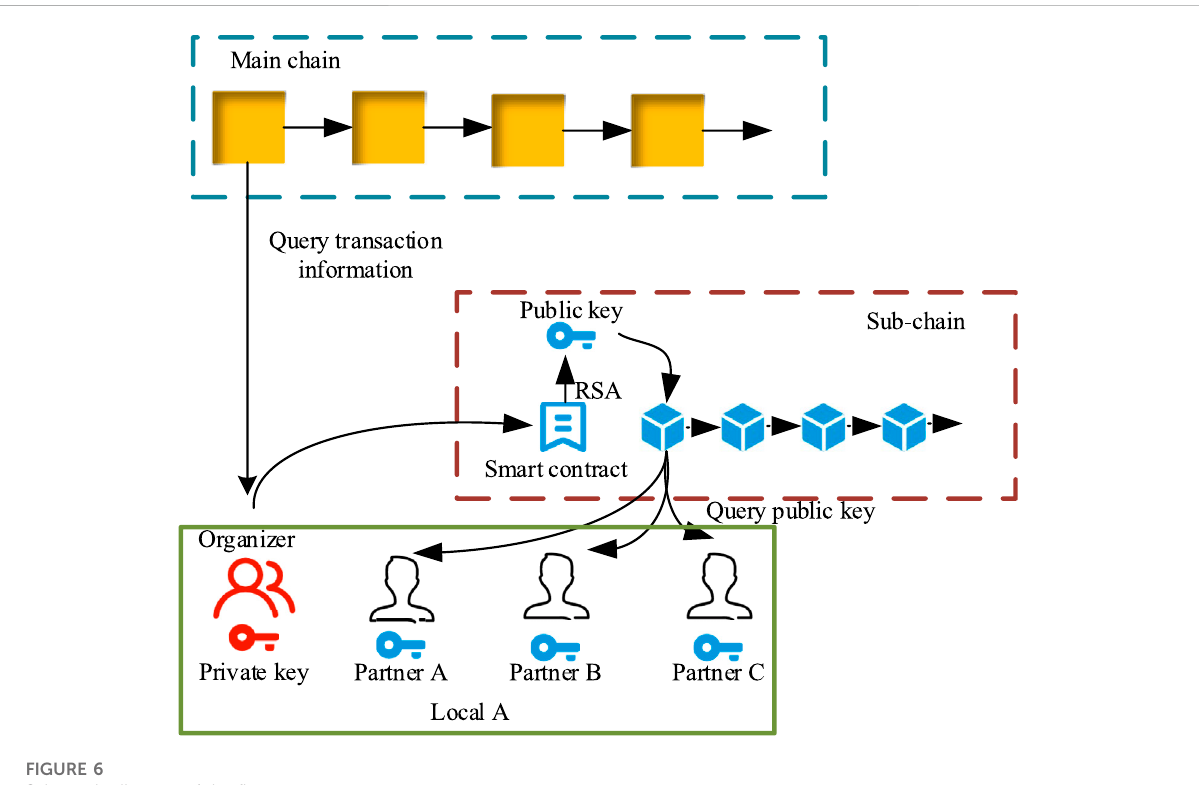
FIGURE 6 Schematic diagram of the fi rst